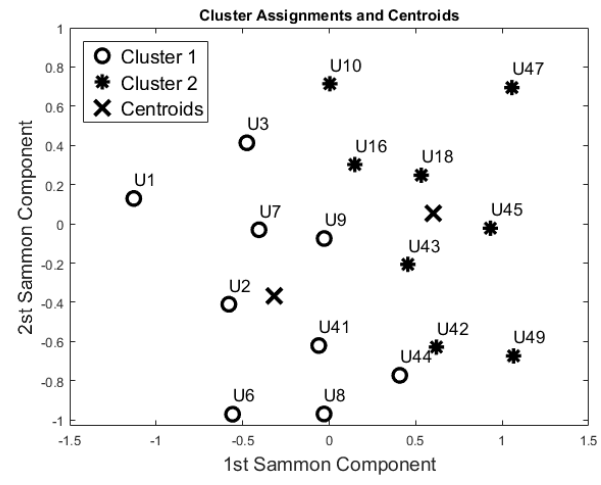
Figure 5. Cluster Analysis on the 24-h period performed on the “55-days” training set. Both unsupervised methods gave similar results.